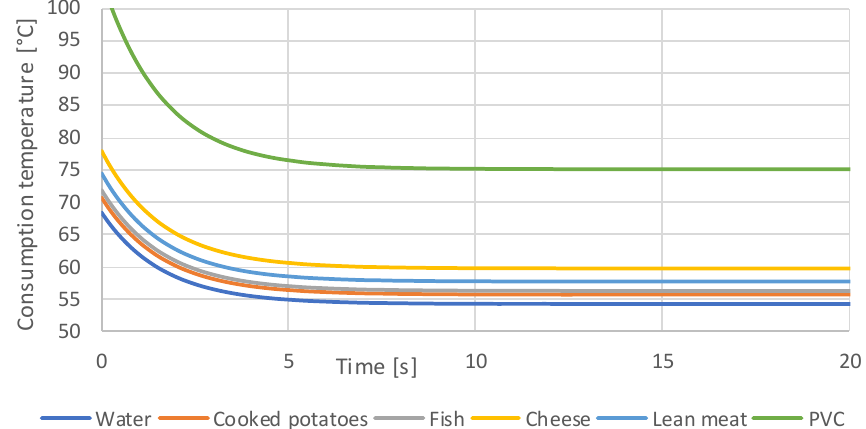
Figure 10. Consumption temperatures of different solid foods calculated from the interpolated curve for the permissible contact temperature in Figure 9; for comparison: water and PVC.